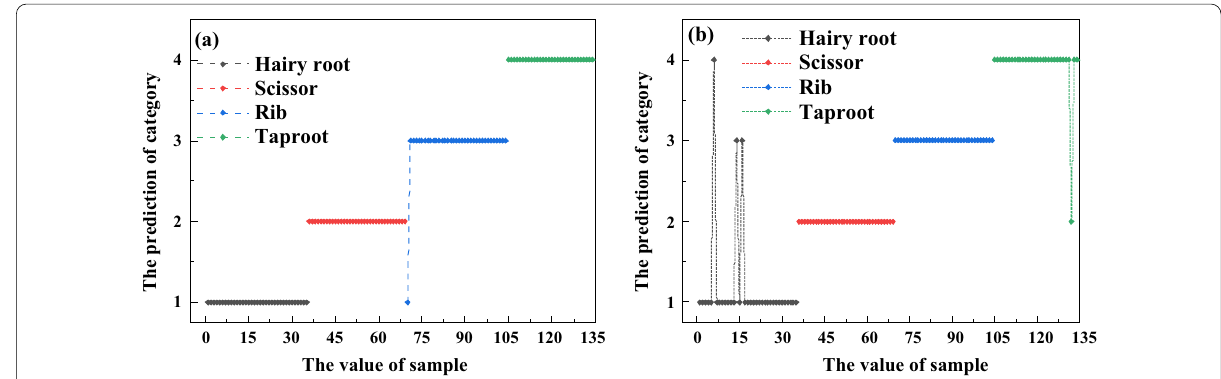
Fig. 5 Test results of SVM, a is the result in LIN‑SVM with baseline correction, and b is the result in RBF‑SVM with MSC